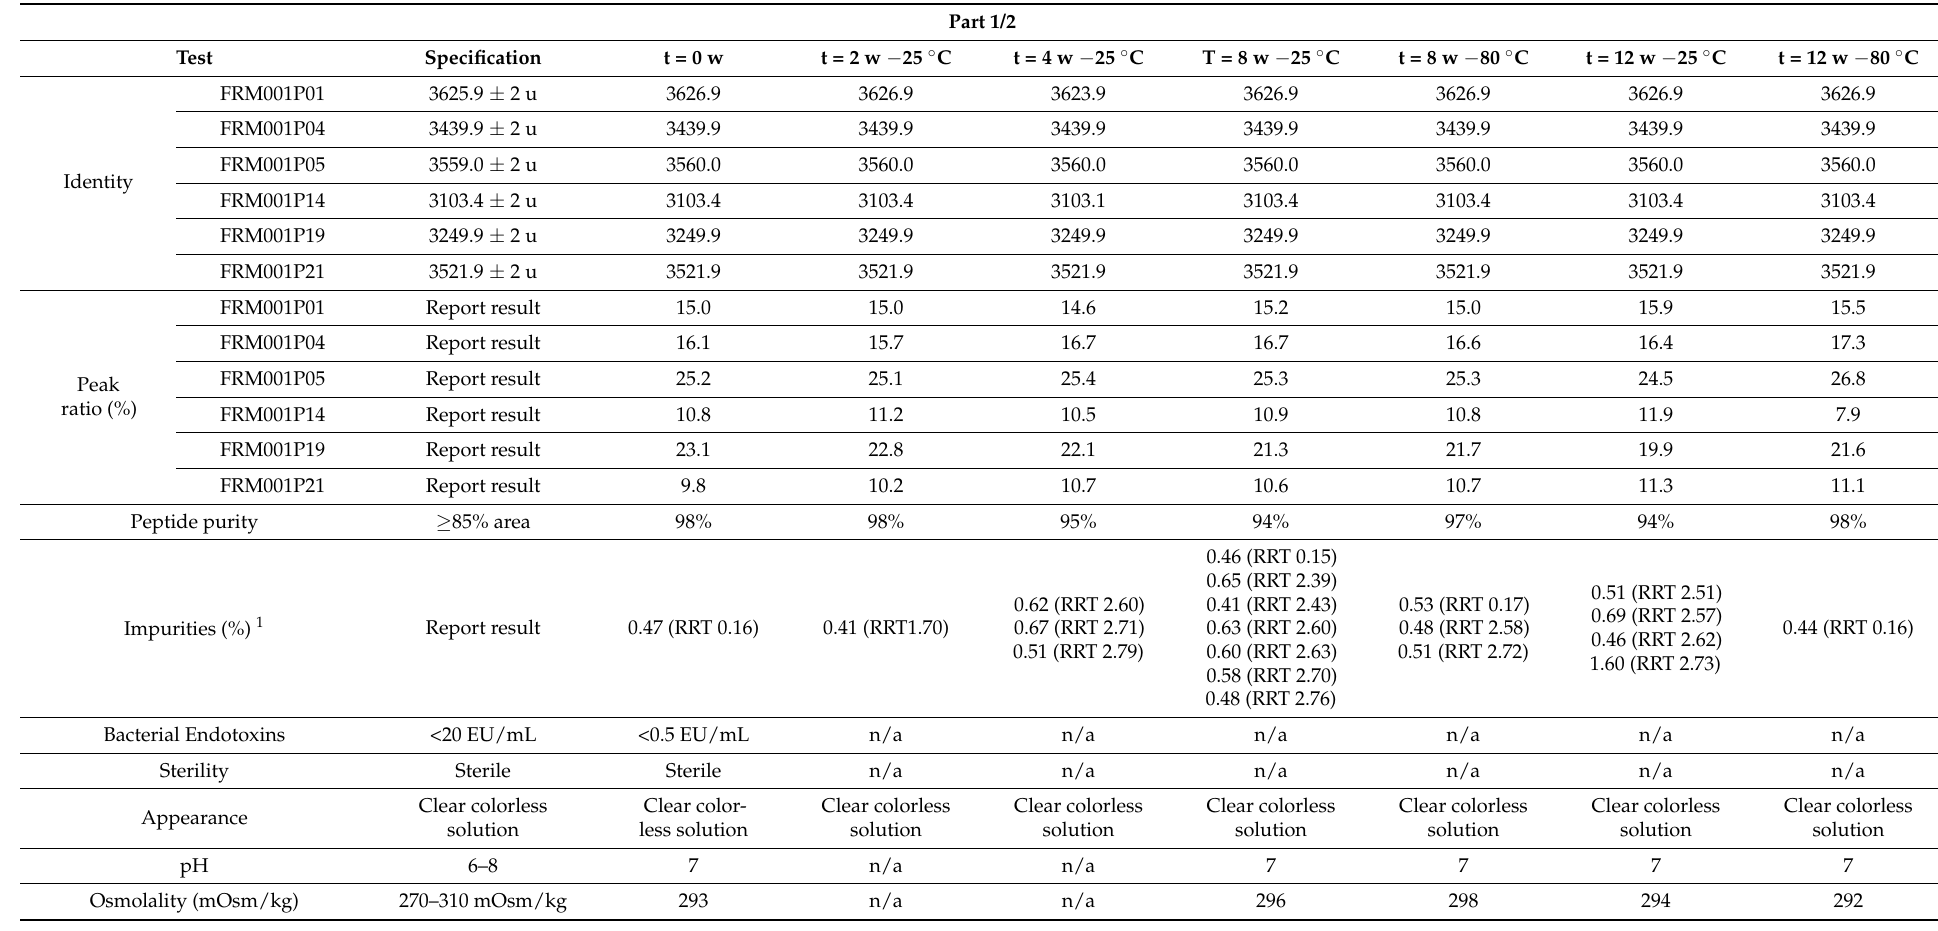
Table 10. The stability results of the FRM001-M1 peptide mixture stored at − 25 ◦ C and − 80 ◦